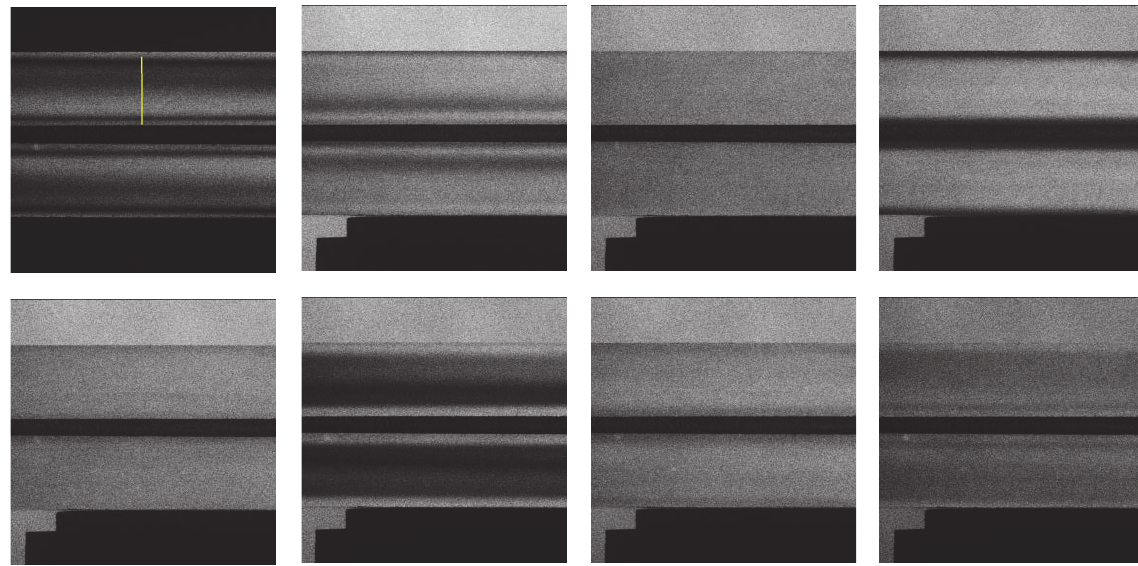
Figure 8: Phase-shifting photoelastic images of laminated directional